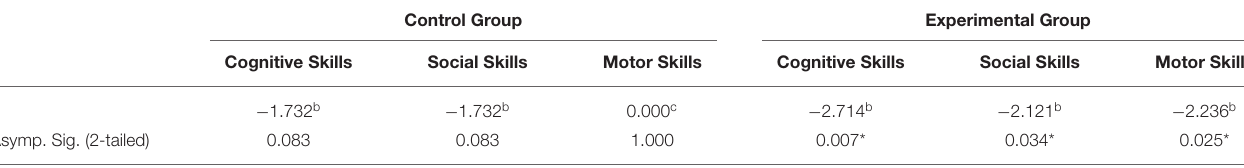
TABLE 4 | Comparison of Pre and Post-tests Means Scores in both Groups.